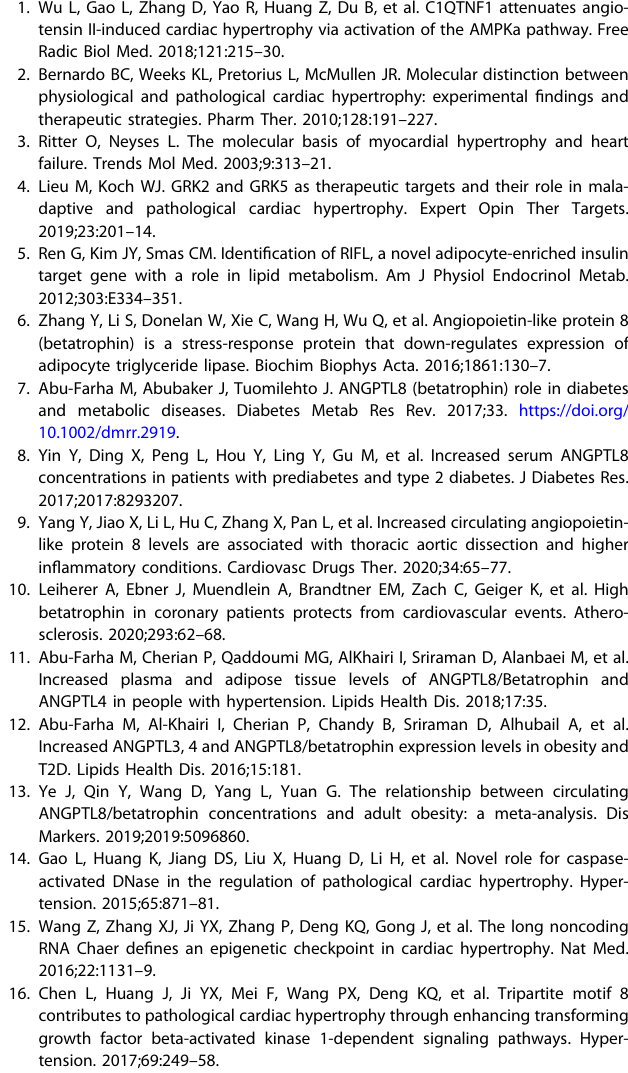
Fig. 8 ANGPTL8 attenuated cardiomyocyte hypertrophy by interacting with LILRB3. A Heatmap analysis of differentially expressed genes is presented. B , C The mRNA levels of PIRA2 and PIRB were determined by qRT – PCR in WT or ANGPTL8-KO mice at 4 weeks after sham or TAC surgery ( n = 5 – 8 in each group). D , E The mRNA levels of PIRA2 and PIRB were detected by qPCR in WT or ANGPTL8-KO mice at 4 weeks after saline or Ang II infusion ( n = 4 – 5 in each group). F , G Representative western blots and quanti fi cation of LILRB3 in NRCM-treated rANGPTL8 and/or Ang II cells (repeated n = 3 per group). H Models of the gene expression system based on chimeric receptors. I A luciferase reporter system detected the interaction between ANGPTL8 and PIRs ( n = 4 – 5). J A schematic diagram of the experimental procedure was used to identify potential targets of ANGPTL8. K Representative Western blots performed with Flag or LILRB3 antibody after co-immunoprecipitation (IP) of ANGPTL8 or LILRB3 from HEK-T293 cell lysates using Flag antibody or LILRB3 antibody, respectively ( n = 3). L , N Representative western blots and quanti fi cation of total and phosphorylated Akt and GSK-3 β in the presence of rANGPTL8 and/or Ang II after LILRB3 siRNA transfection ( n = 3). O , P Representative microscopic images of rhodamine phalloidin staining and quantitative results of the cell surface of NRCM treated with Ang II and/or rANGPTL8 in the presence of siRNA-LILRB3 for 48 h ( n > 50 cells in each group, 5 independent experiments, scale bars, 100 μ m and 50 μ m, respectively). Q , R The mRNA levels of the hypertrophic genes ANF and BNP were detected by qPCR in the indicated groups ( n = 5). * P < 0.05, ** P < 0.01, *** P <